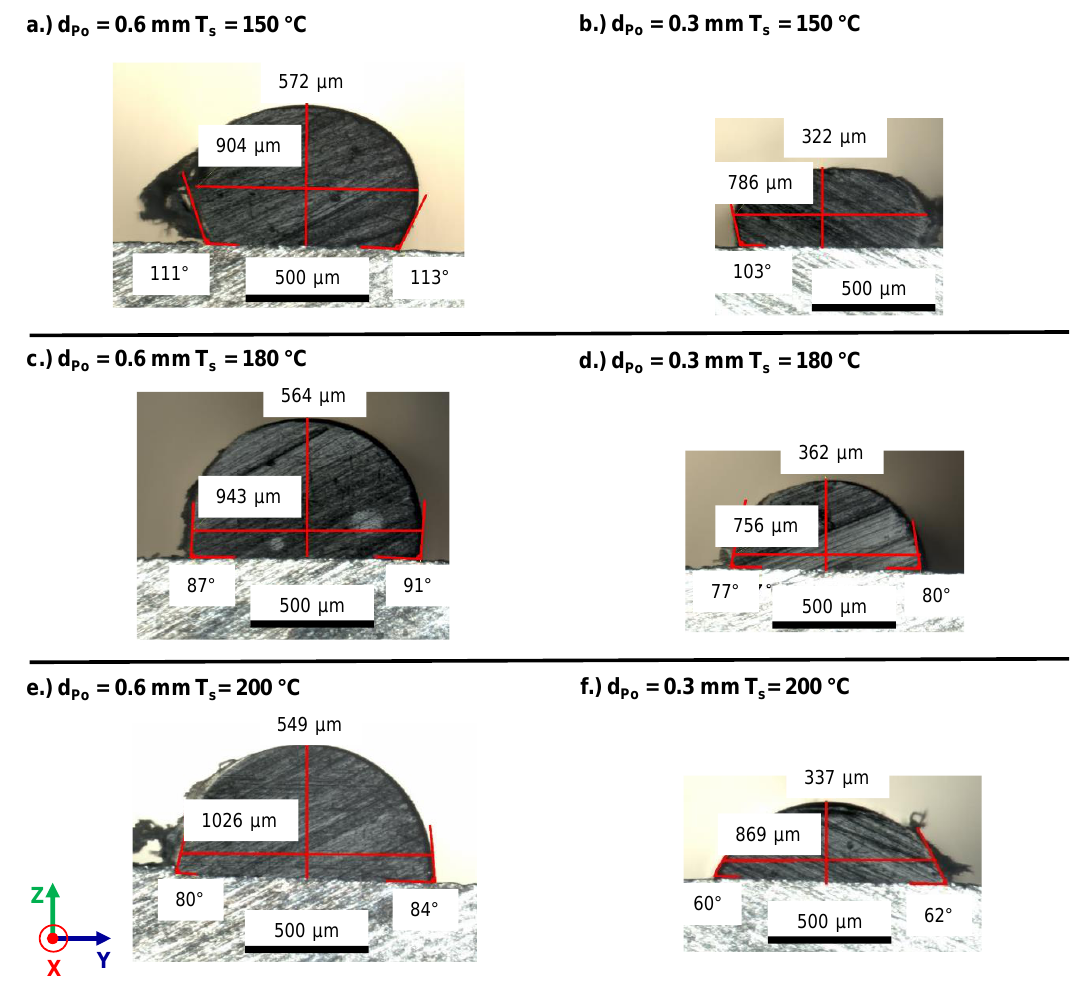
Figure 11. Brightfield light microscopic images for contact angle measurement for d Po = 0.6 mm ( a , c , e ) and d Po = 0.3 mm ( b , d , f ) high traces deposited on a substrate with a temperature of T s = 150 ◦ C ( a , b ), T s = 180 ◦ C ( c , d ) and T s = 200 ◦ C ( e , f ).